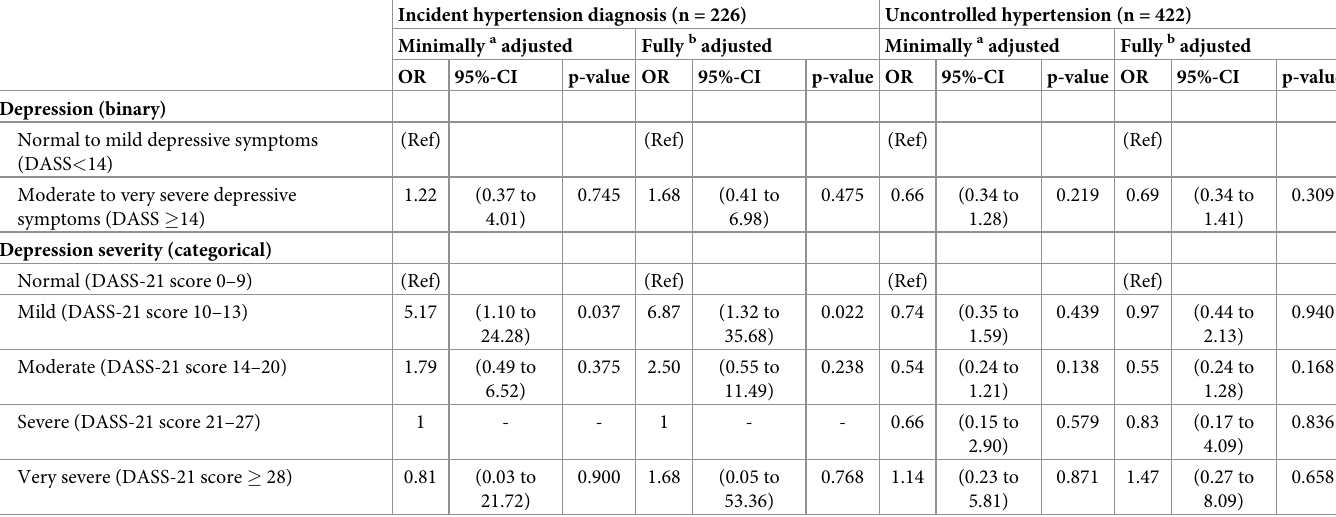
Table 4. Prospective association between depression and incident hypertension diagnosis as well as uncontrolled